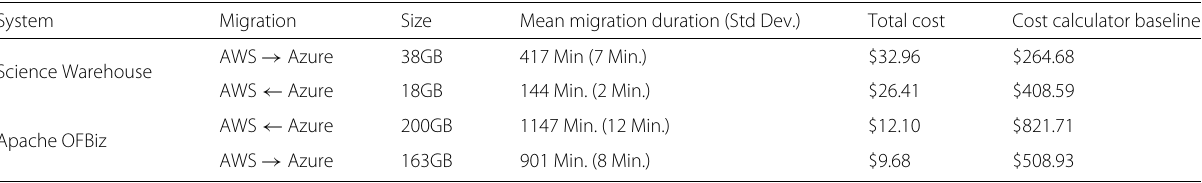
Table 4 Predicted migration costs